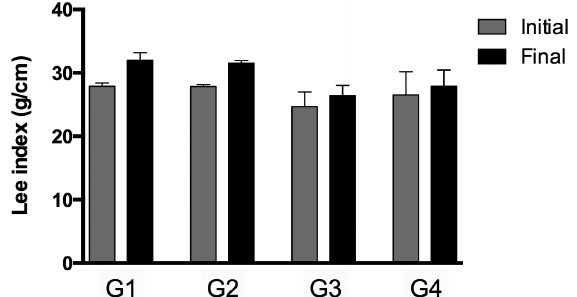
Figure 3 - Initial and fi nal Lee Index (g/cm) of non-exercised and exercised rats supplemented or not with coconut oil. Data shown as mean ± standard error. G1 = Sedentary and Non-supplemented (Control Group), G2 = Sedentary and Supplemented Group, G3 = Physical Exercise and Non- supplemented Group, and G4 = Physical Exercise and Supplemented Group. Non-signi fi cance (ANOVA followed by Holm-Sidak test).